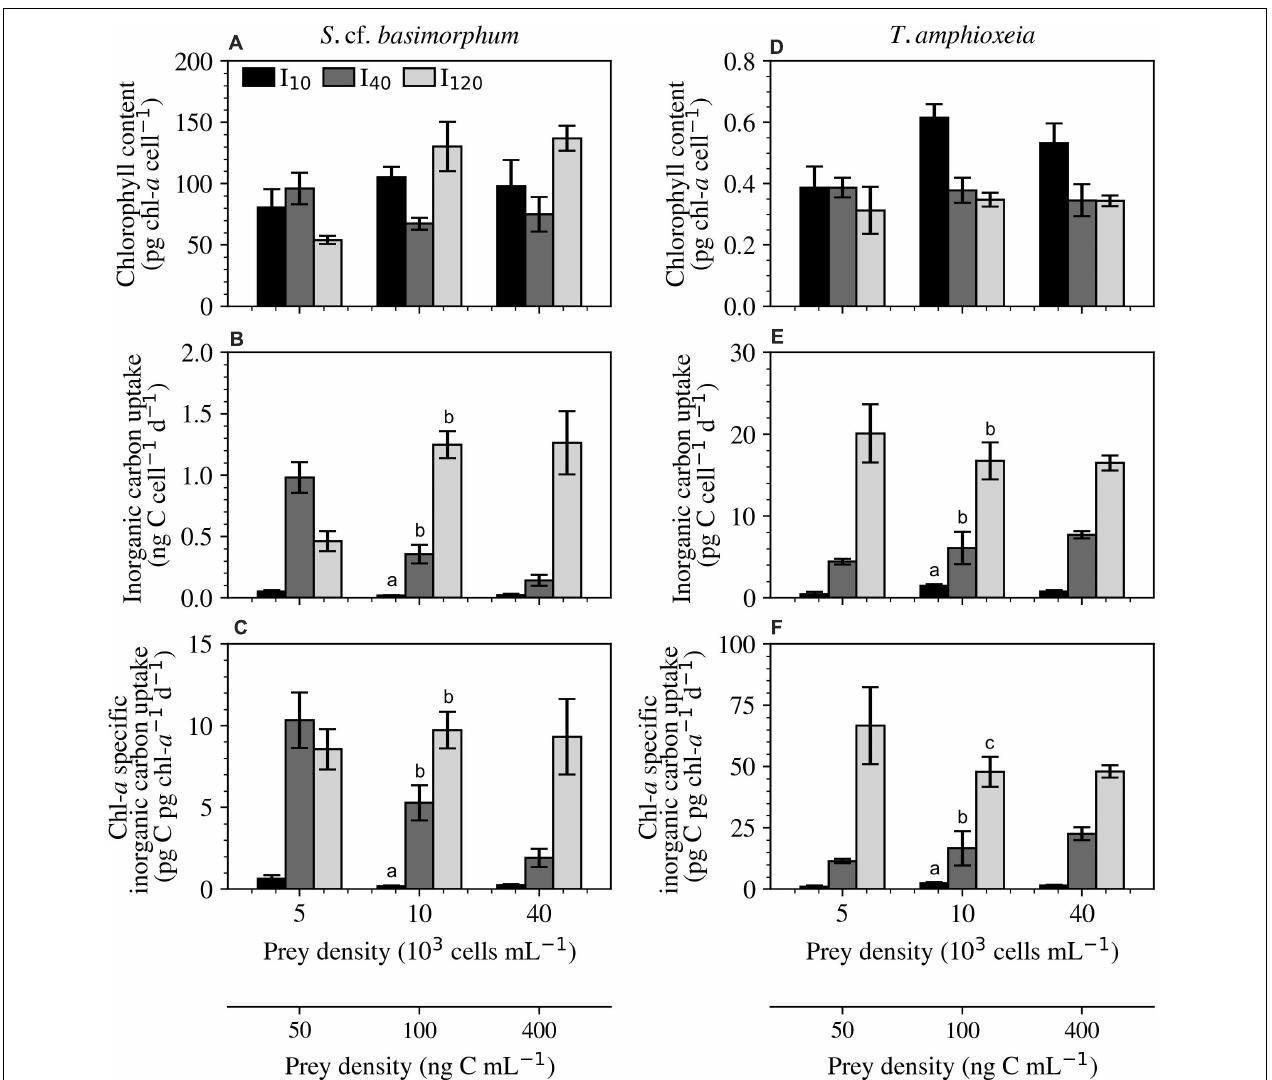
FIGURE 5 | Experiment 2: Physiological responses of Strombidium cf. basimorphum (A–C) and T. amphioxeia (D–F) at the three light (I 10 , I 40 , and I 120 ) and three prey density treatments (50, 100, and 400 ng C mL − 1 ). (A,D) Cellular chl- a content. (B,E) Daily cellular inorganic carbon uptake rate. (C,F) Daily chl- a specific inorganic carbon uptake rate. Black, dark gray, and light gray bars denote light treatments I 10 , I 40 , and I 120 , respectively. Data points are means ± STD ( n = 9). Prey density was not proven to be statistically significant for any of the displayed variables; the letters, therefore, represent statistically similar groupings based only on the overall effects of irradiance across all prey density treatments. Subplots without letters did not show significant effects of prey density or